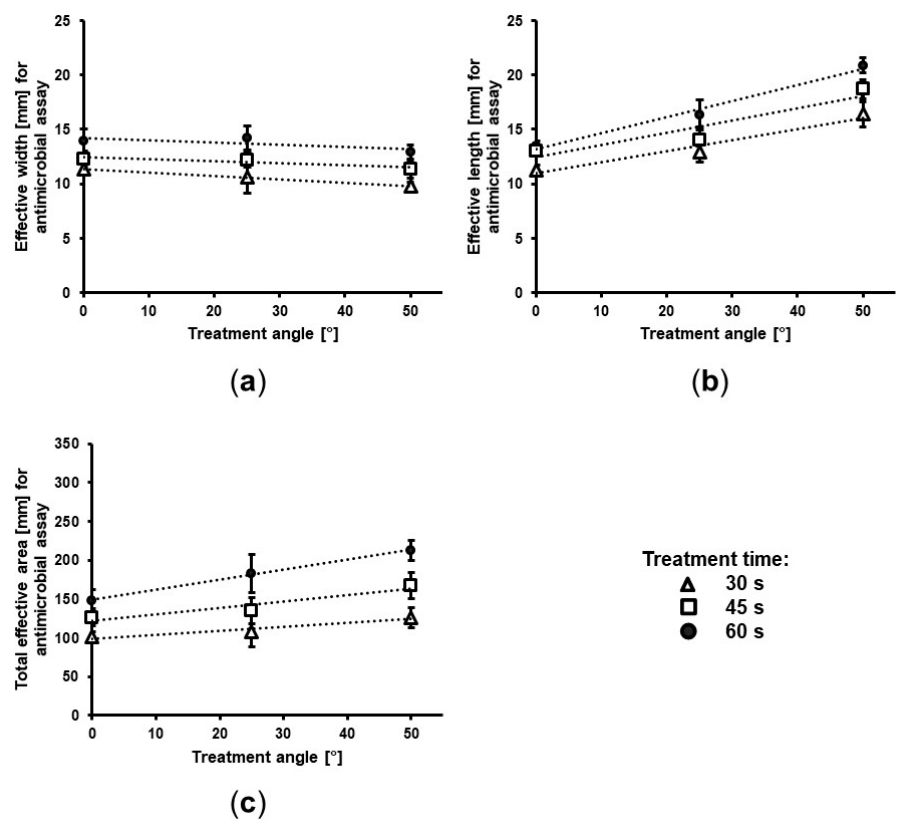
Figure 6. Alteration of ( a ) width, ( b ) length and ( c ) total area depending on incidence angle (0 ◦ , 25 ◦ , 50 ◦ ) and plasma treatment time (30, 45 and 60 s) of inoculated agar plates ( Staphylococcus aureus DSM 799 / ATCC 6538) with kINPen ® MED- β (M ± SD, n = 6). After the visualization of the biological e ff ective area for the kINPen ® MED- β , the question arose if this shape–in particular, the elliptical shape–of the inhibition zone during tilted treatment can be correlated with a non-biological parameter (Figure 5b). Therefore, the reactive oxygen species (ROS) and (vacuum) ultraviolet (V)UV distribution on the treated surface was analyzed with regard to the influence of the incidence angle on the shape of the e ff ective area on a treated surface.